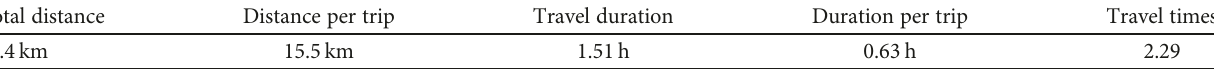
Table 1: The involved fi ve factors for EV traveling pattern